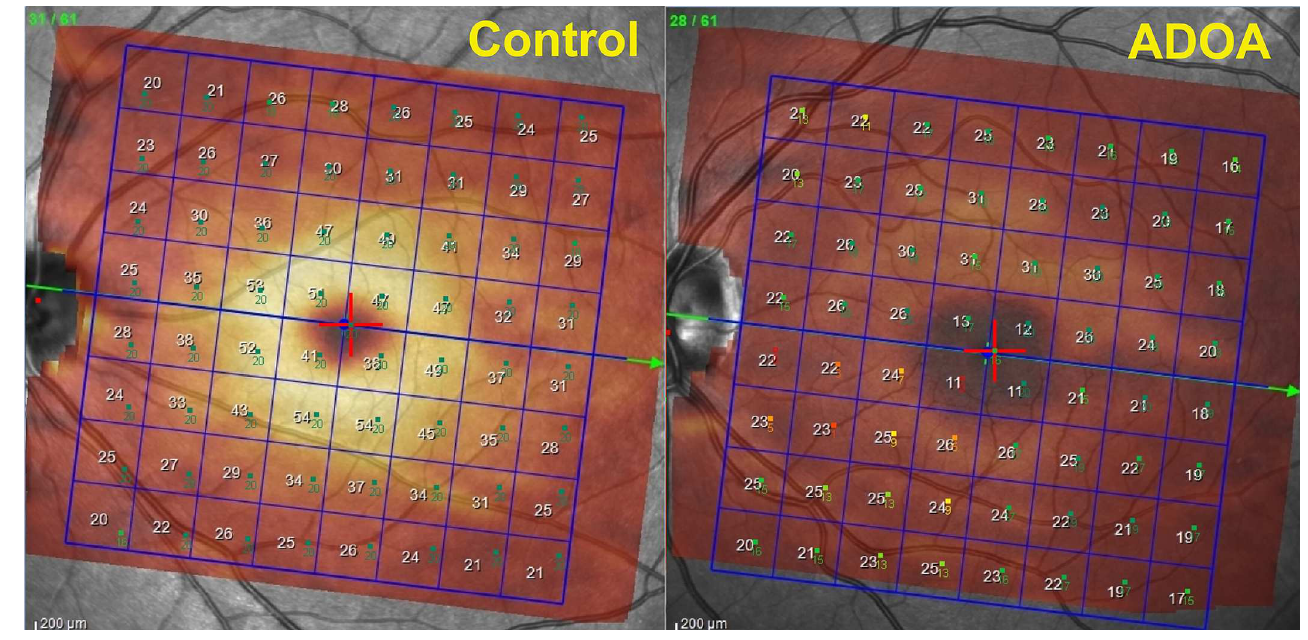
Fig 5. Combination map of SD-OCT GCL and MP1 PP map of a healthy subject vs ADOA patient.